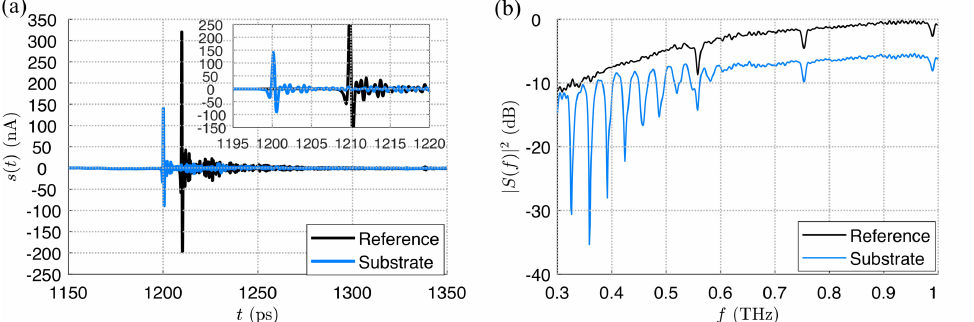
Figure 2. ( a ) Time-domain signal s ( t ) measured for the reference (reflection from the metallic baseplate) and in the presence of the RO3010 substrate. The pulse around 1200 ps (light blue curve) preceding the reference one stems from reflection from the top surface of the substrate. A zoomed inset is reported at the top-right corner to better show the shape of the pulses. ( b ) Fourier transformed power spectra of the time-domain signals. The three major dips in the reference spectrum are due to water absorption.